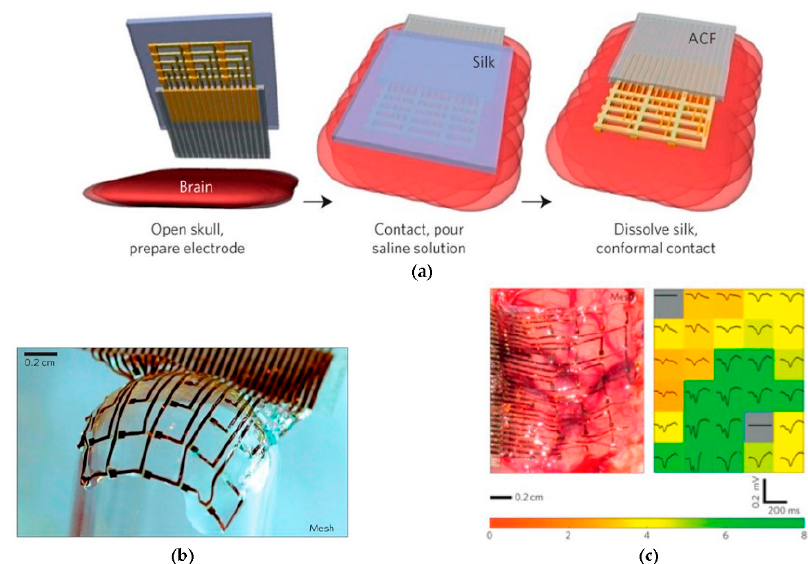
Figure 7. ( a ) Schematic illustration of clinical use of a representative device in an ultrathin mesh geometry with a dissolvable silk support; ( b ) Image of the mesh electrodes array; ( c ) Image of the mesh electrode array on a feline brain (left) and the average evoked response from each electrode (right) with the colour showing the ratio of the rms amplitude of each average electrode response in a 200 ms window. Reprinted by permission from Macmillan Publishers Ltd.: Nature Materials [27], copyright 2010.